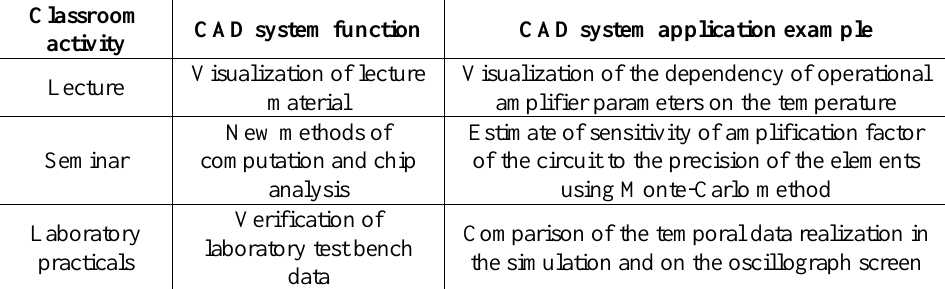
Table 1. CAD system functions by the kind of classroom